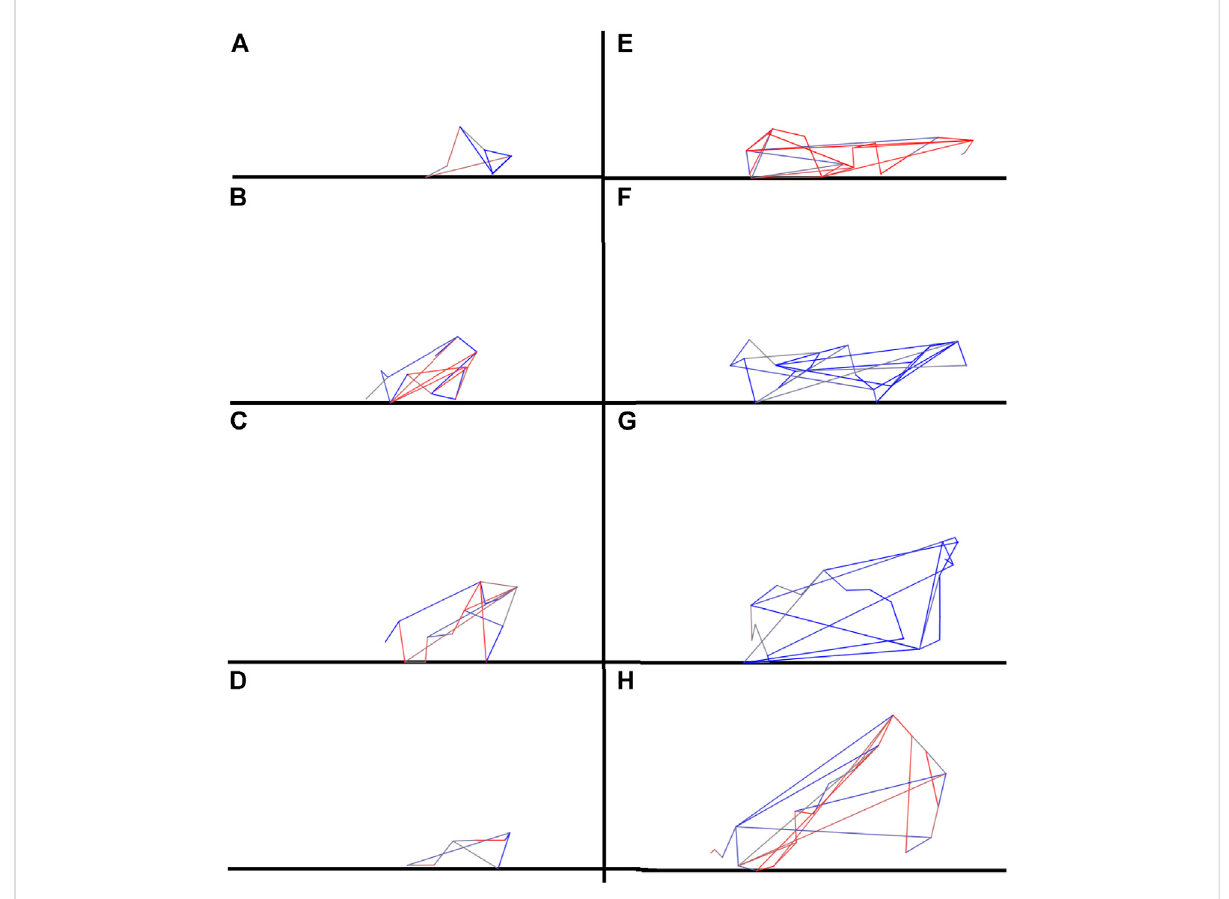
FIGURE 4 Examplesofrobotsevolvedwiththestandardandcomplexity-biasedalgorithm,left (A – D) andrightrespectively (E – H) .Theagentsshownwere selected among the best performing agents. The link to the videos of the corresponding behaviors are included in the Appendix A. The colored lines indicate the springs forming the robot ’ s body. The colors indicate the contraction/extension phase of the